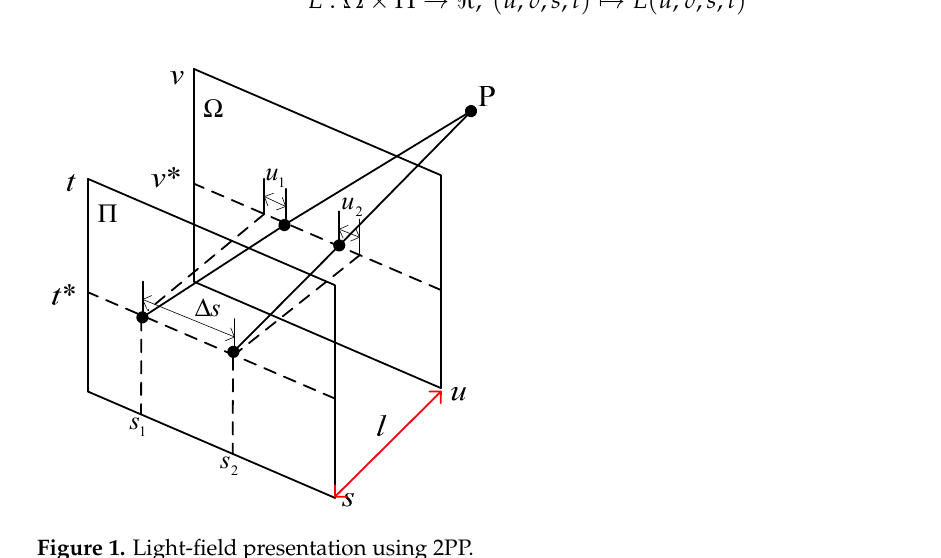
Figure 1. Light-field presentation using